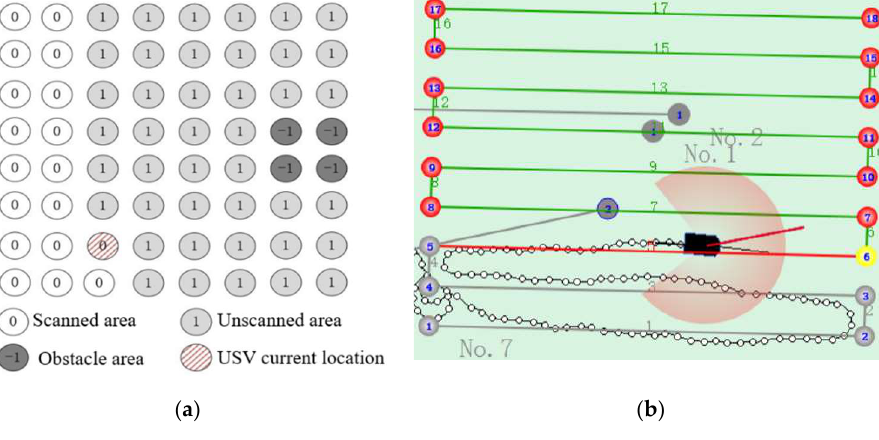
Figure 13. ( a ) Environmental modeling. ( b ) The planned path of the mission.